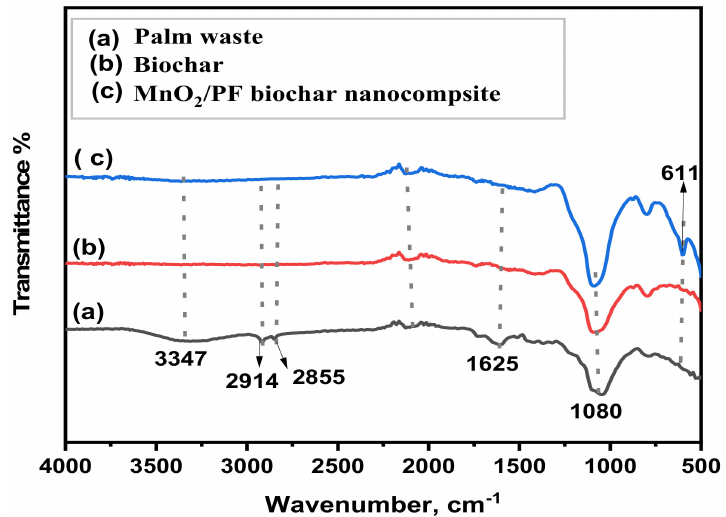
Figure 3. FTIR spectrum of ( a ) palm waste, ( b ) biochar, and ( c ) MnO 2 /PF biochar